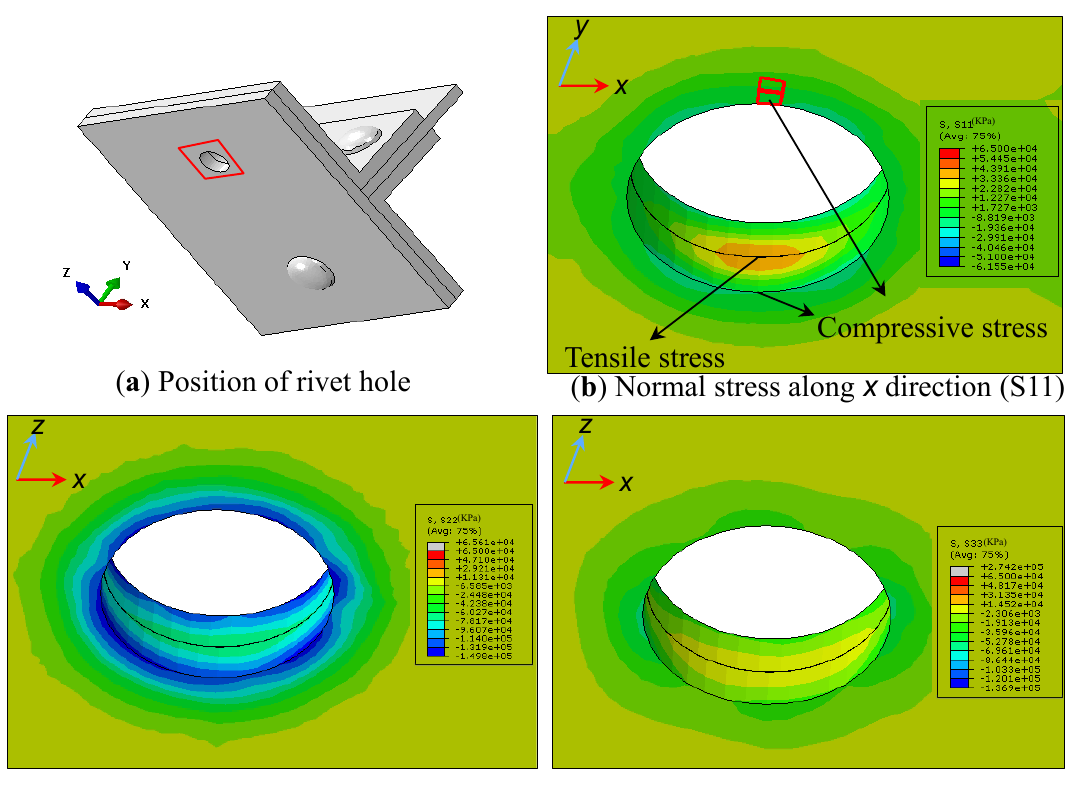
( c ) Normal stress along y direction (S11) ( d ) Normal stress along z direction